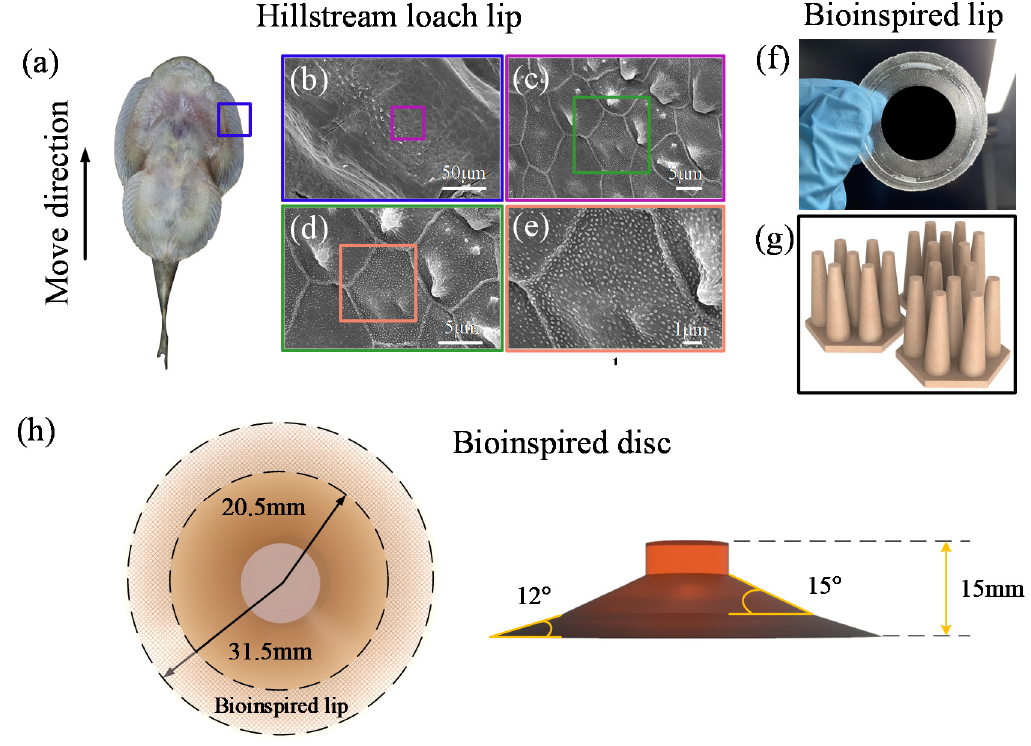
Figure 1. Structure of the hillstream loach biological disc and bioinspired disc: ( a – e ) morphology of the structure of the lip of the hillstream loach disc. Blue frame represents the fins of the hillstream loach, purple frame represents the hexagonal epithelial cells, green frame represents a single hexagonal pillar, and orange frame represents the setae; ( f ) synthetic bioinspired lip; ( g ) bioinspired hierarchical microstructure; ( h ) bioinspired disc.